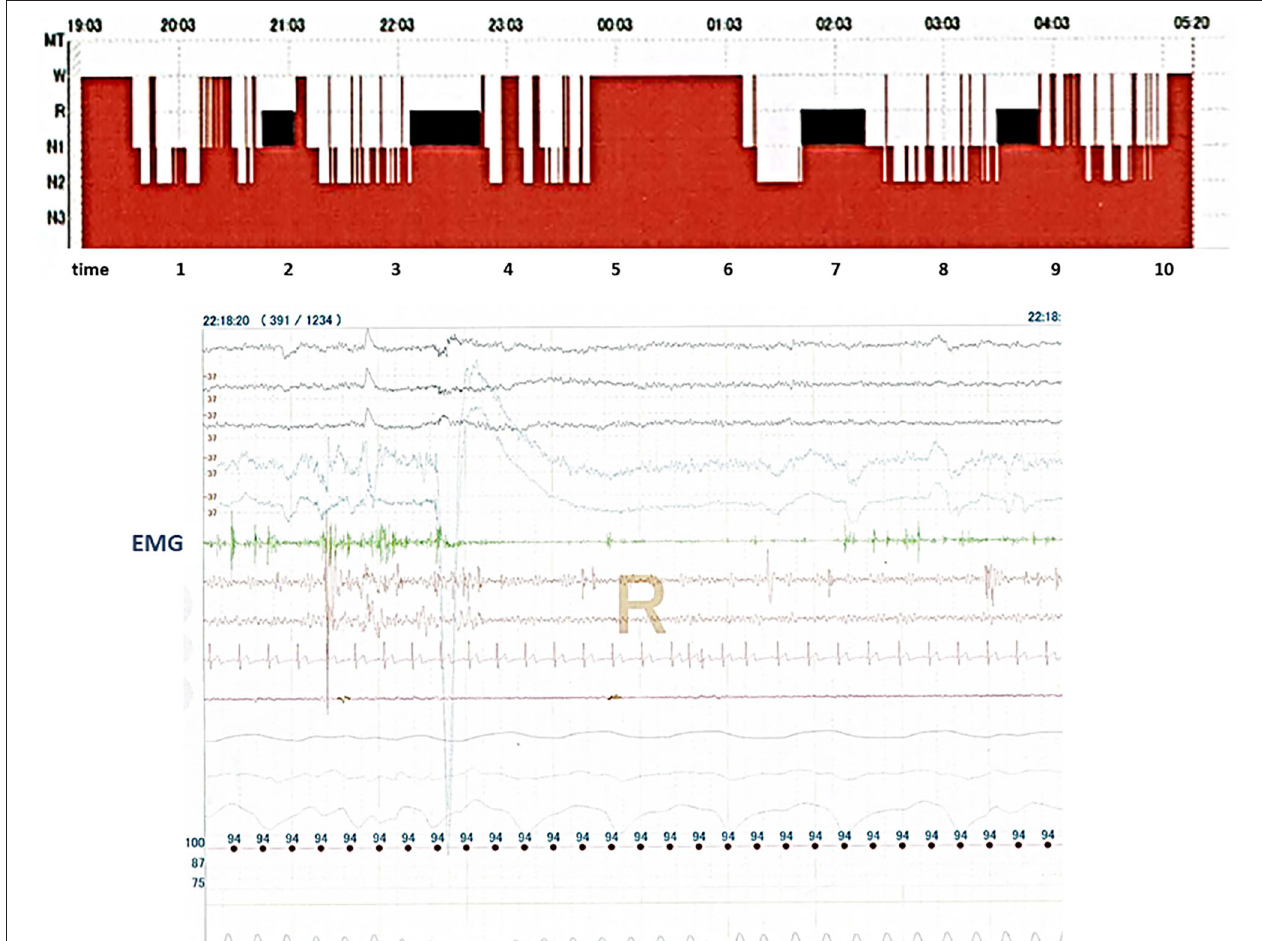
FIGURE 2 | It shows records of polysomnography (PSG) in Case 11. The top part of the figure shows sleep stages in Case 11, and the bottom part of the figure shows records from many physiological signals including electroencephalograms, electrooculograms, electromyograms (EMG), nasal–oral flow, chest and abdominal movements, electrocardiograms, and arterial oxygen saturation which obtained PSG in Case 11. REM sleep without atonia is seen on the record of EMG channels during